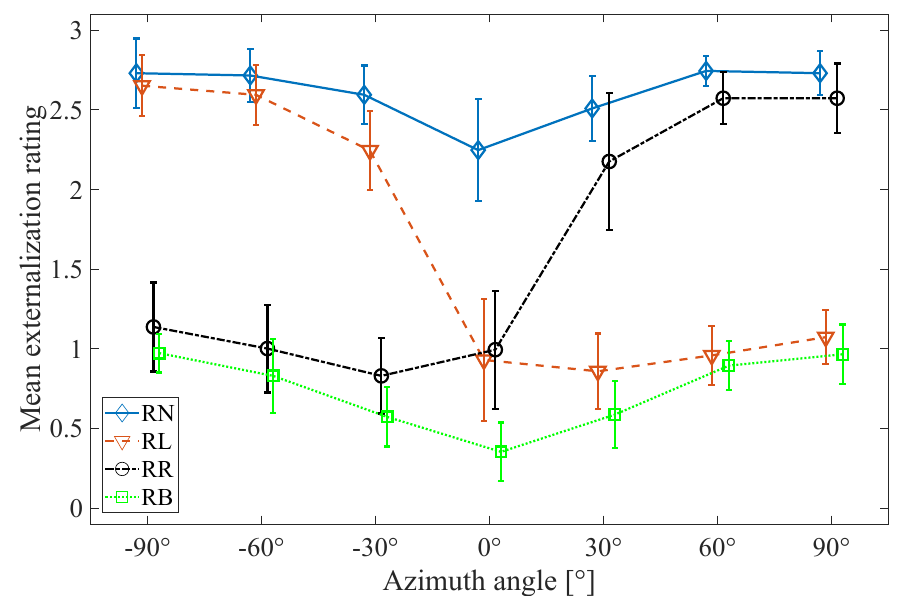
Figure 9. Mean externalization ratings from zero (the sound is in my head) to three (the sound is externalized and at the position of the loudspeaker) across listeners for the “RN” (diamonds), “RL” (triangles), “RR” (circles), and “RB” (squares) conditions in different azimuth angles. The error bars indicate the standard deviations of the mean